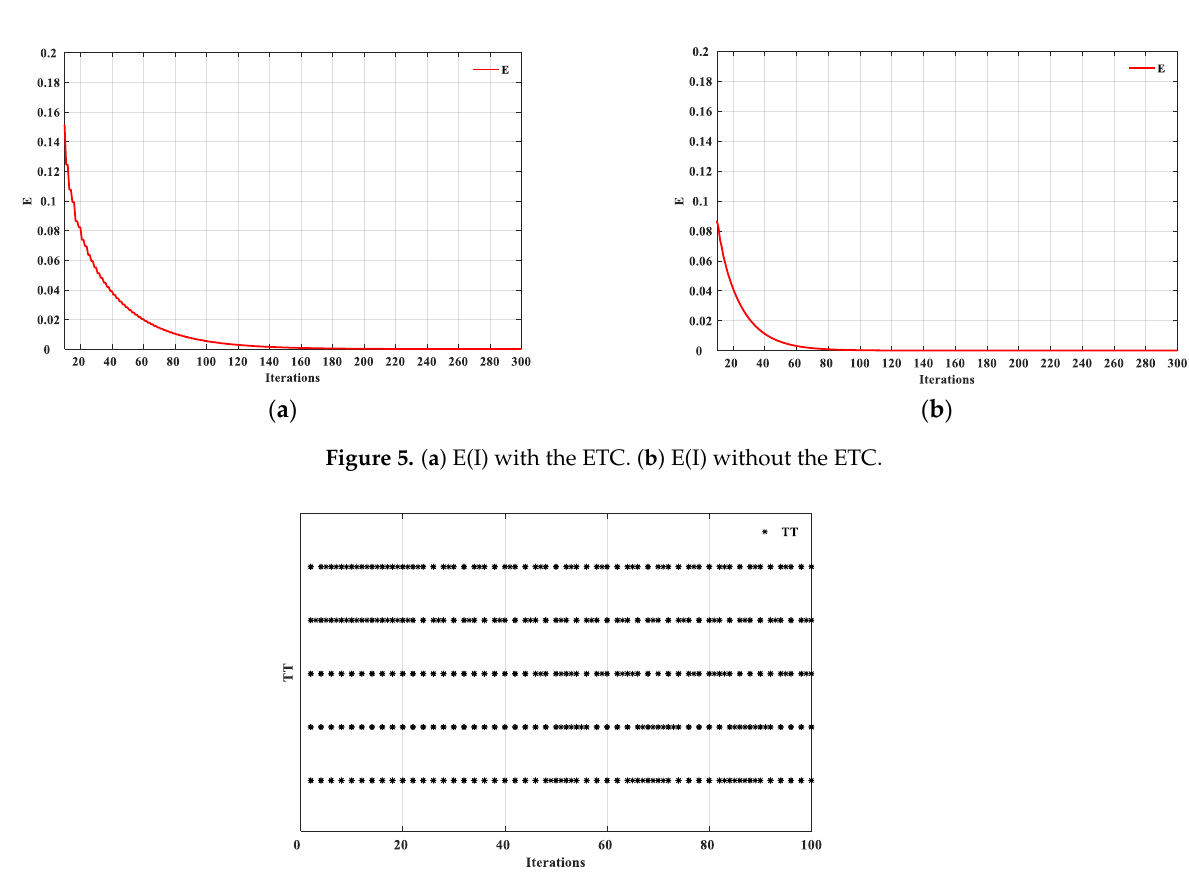
Figure 4. ( a ) q / c ratio result with the ETC. ( b ) q / c ratio result without the ETC.